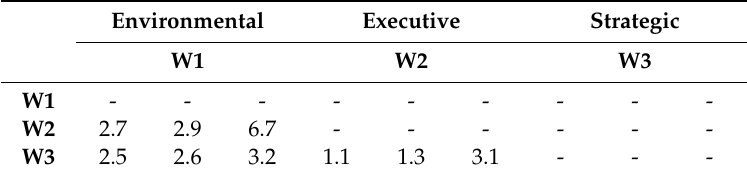
Table 9. Paired comparison matrix of KPIs in the FMCG industry green supply chain, based on integration of experts.